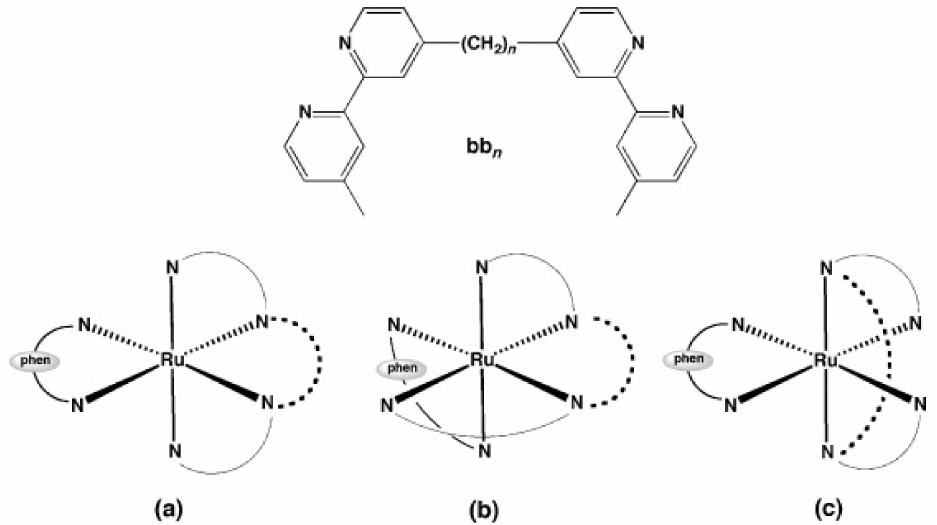
Figure 7. The ligand bb n and the possible isomeric forms of the mononuclear complex [Ru(phen)(bb n )] 2+ with bb n as a tetradentate ligand: ( a ) cis - α isomer, ( b ) cis - β isomer, and ( c ) a form in which the central polymethylene chain spans the trans . Reproduced from [48] with permis- sion. Copyright © 2015 WILEY-VCH Verlag GmbH & Co. KGaA, Weinheim. Mononuclear Ru (II) Heteroleptic Complexes Bearing Pyridophenazine Ligands [Ru(phen) 2 (dppz)] 2+ (Figure 8), where dppz = dipyrido[3,2- a :2’,3’-c]phenazine and phen = 1,10-phenanthroline, displayed good bactericidal activity against M. smegmatis (MIC = 2 µ g/mL). Its mechanism of action was suggested to be linked to ROS generation and DNA intercalation [93]. A similar complex, [Ru(2,9-Me 2 phen) 2 (dppz)] 2+ , was active against MRSA and B. subtilis , and displayed time–kill curves that were similar to those of currently used antibiotics, but displayed no activity against E. coli . The activity appeared to be correlated with the ability to intercalate into DNA double strands in vitro. In vivo antibacterial activity has been assessed using the nematode Caenorhabditis elegans infection model and [Ru(2,9-Me 2 phen) 2 (dppz)] 2+ proved to be non-toxic to the nematodes